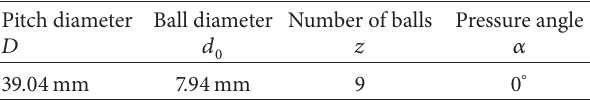
Table 3: Parameters of the 6205-2RS JEM SKF